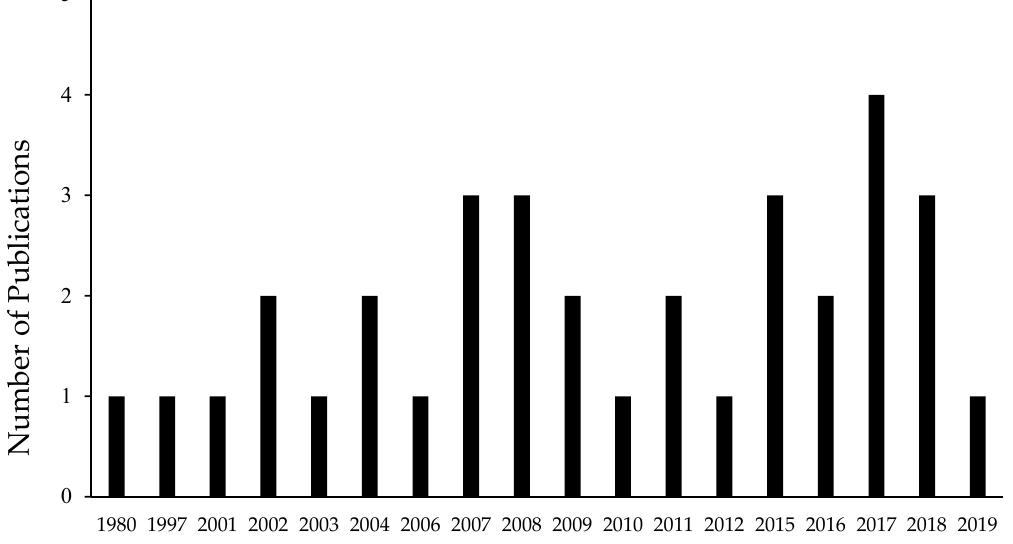
Figure 2. Numbers of publications per year across all studies included in the review.